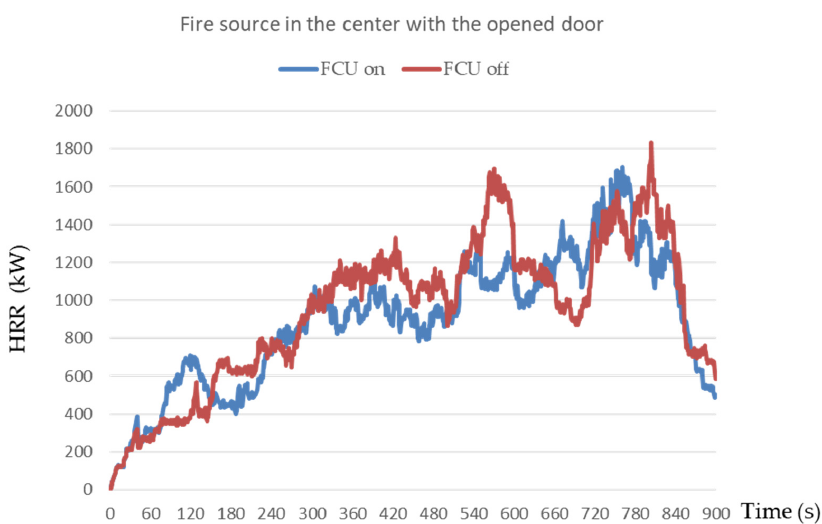
Figure 5. The HRR for different actions of the air inlet with the fire in the center of the square room.